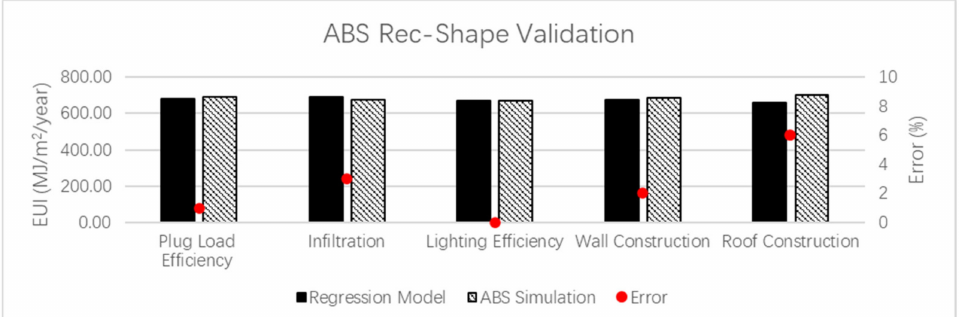
Figure 9. ABS Case study validation—Rectangle